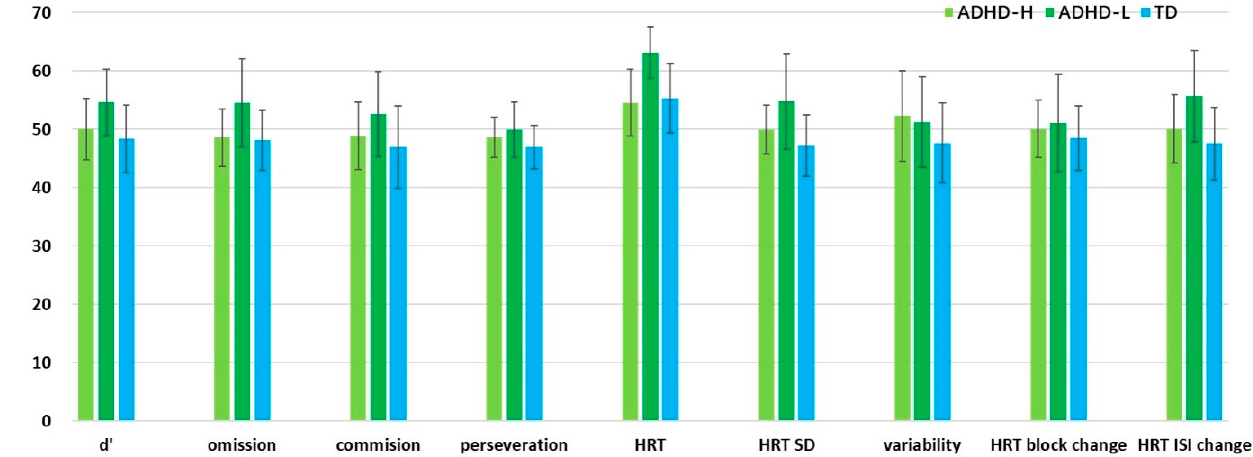
Figure 5. KCPT score among groups.